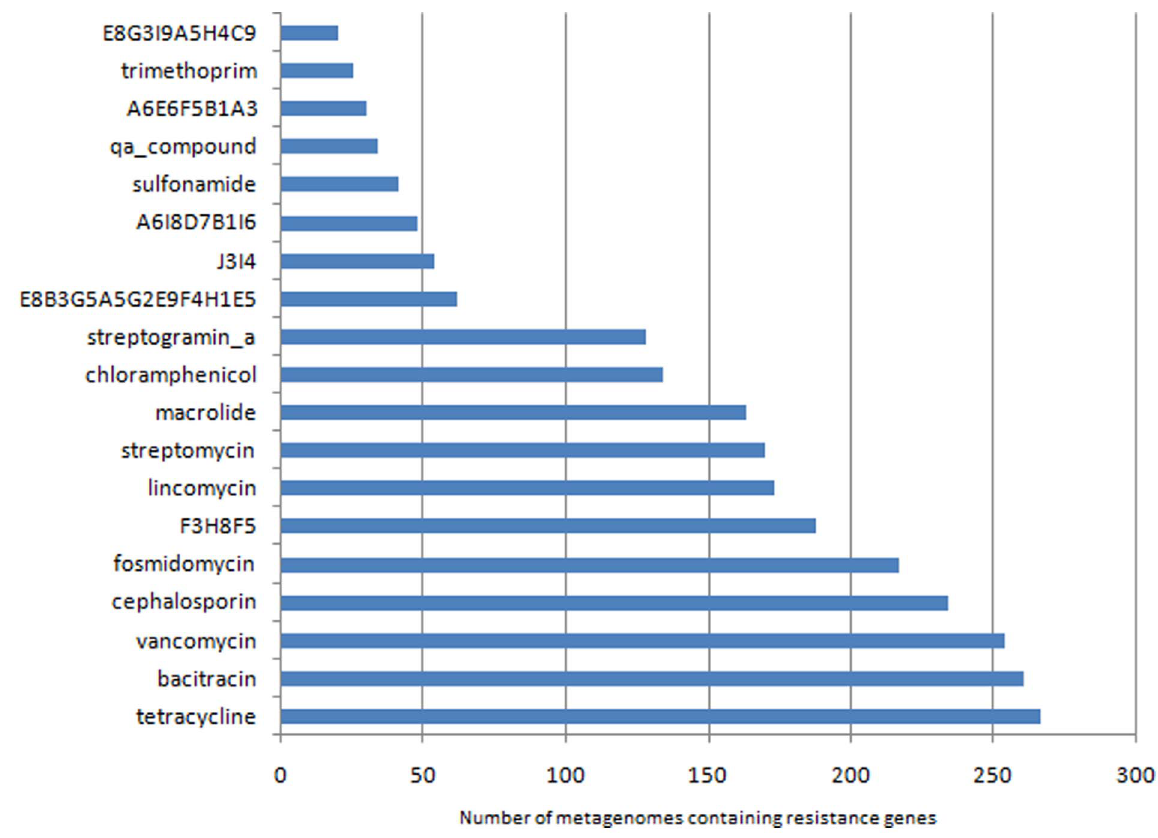
Figure 1. Number of gut metagenomes containing genes resistant to various antibiotics.